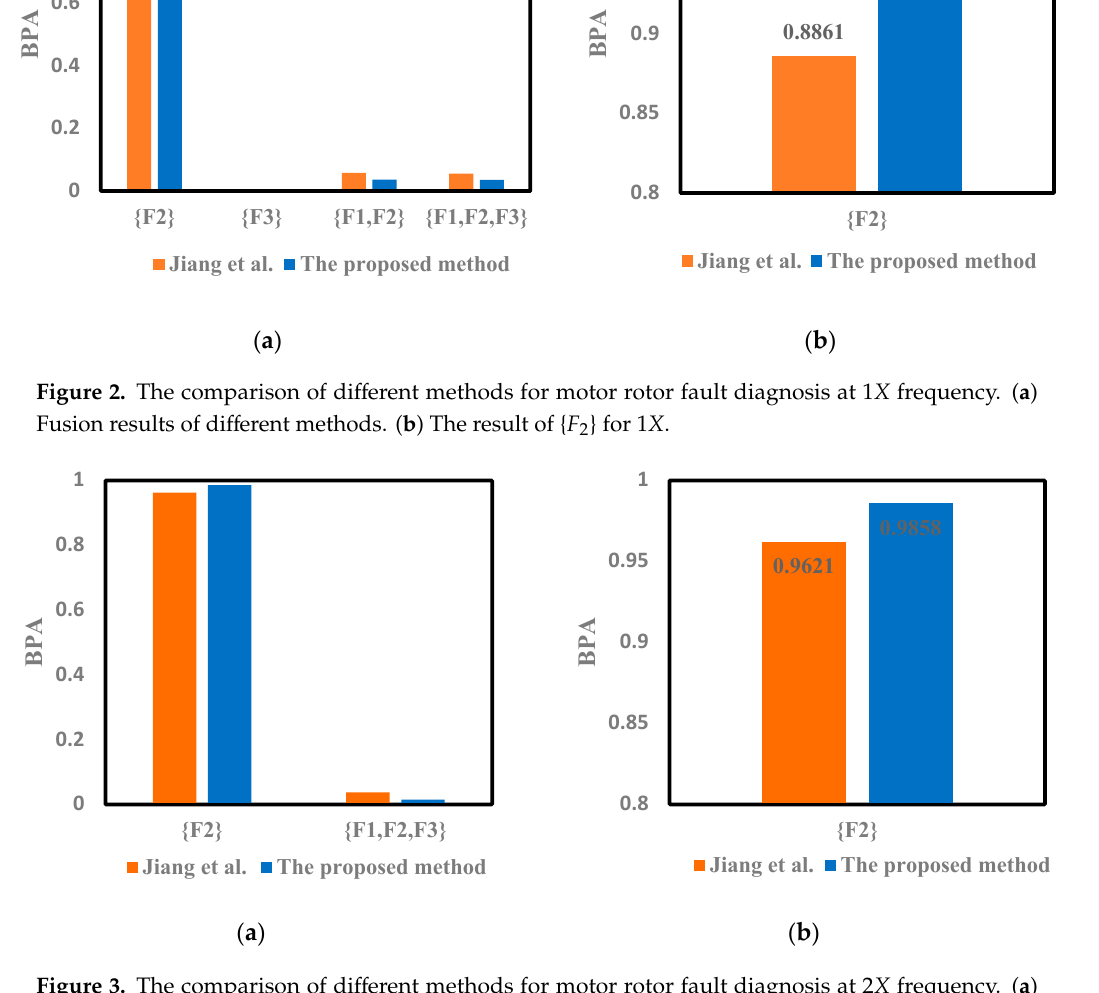
Figure 3. The comparison of di ff erent methods for motor rotor fault diagnosis at 2 X frequency. ( a ) Fusion results of di ff erent methods. ( b ) The result of { F 2 } for 2 X